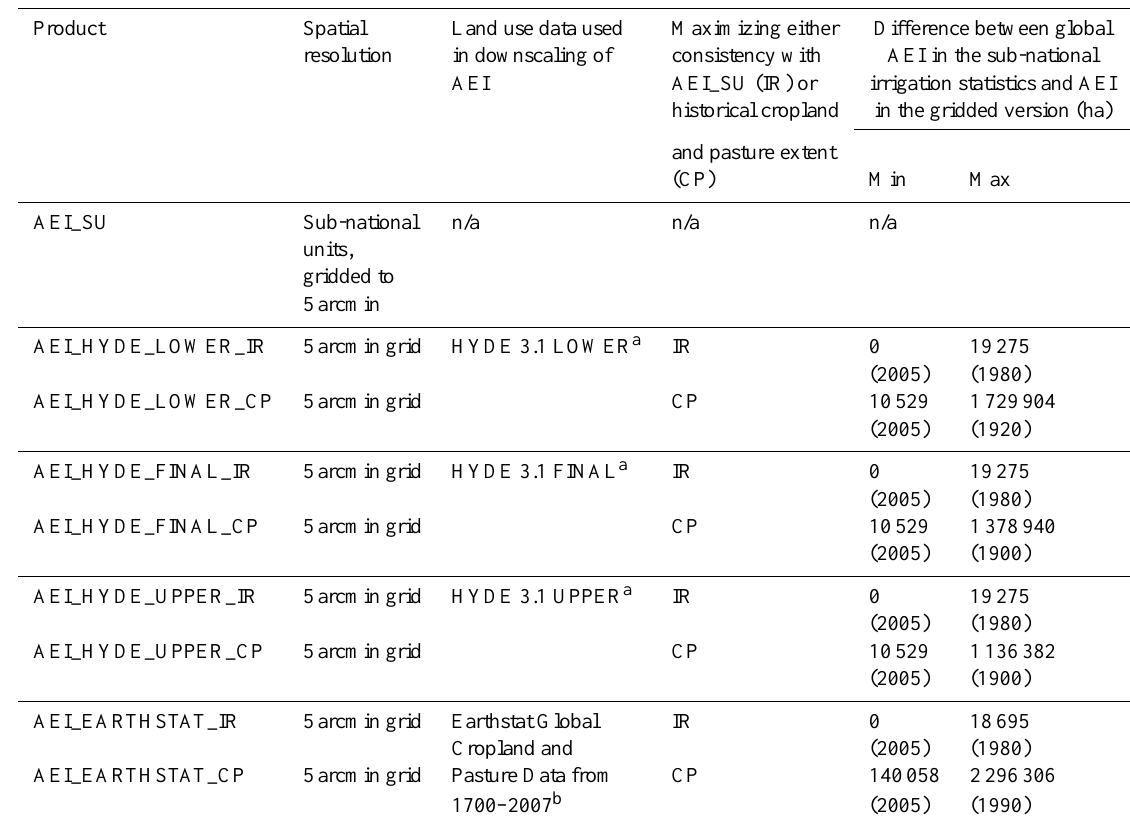
Table 1. Spatial resolution, land use data used in downscaling of area equipped for irrigation (AEI) compiled from sub-national statistics (AEI_SU), consistency rules in downscaling and AEI lost in downscaling for products in the global historical irrigation data set HID. Product Spatial Land use data used Maximizing either Difference between global resolution in downscaling of consistency with AEI in the sub-national AEI AEI_SU (IR) or irrigation statistics and AEI historical cropland in the gridded version (ha) and pasture extent (CP) Min